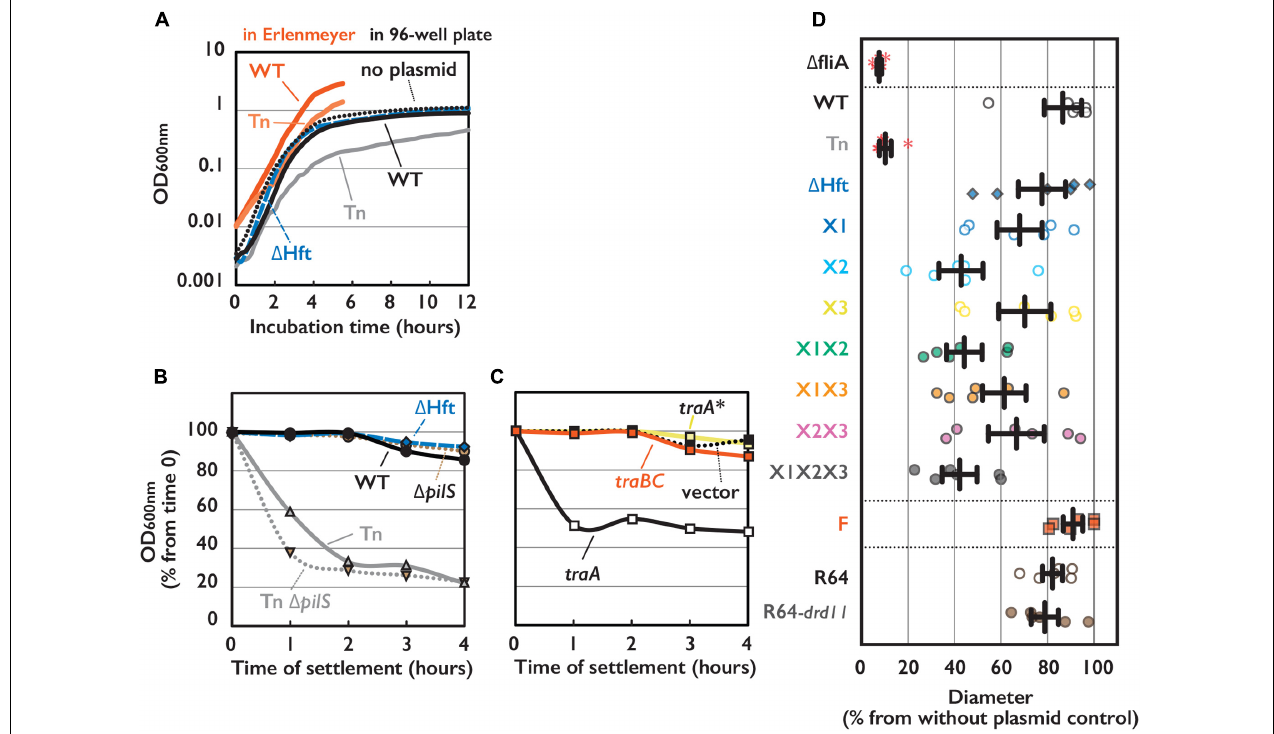
FIGURE 2 | Phenotypes of E. coli cells harboring conjugative plasmid. (A) Cell growth of E. coli strain harboring indicated plasmid measured by OD 600 nm with either conventional spectrometer or 96-well plate reader. (B,C) Sedimentation phenotype measured by OD 600 nm of culture supernatant settled on bench for indicated time. E. coli cells harboring WT or mutant of pESBL as indicated (B) or WT pESBL and an extra plasmid indicated for overexpression (C) . Average of at least 3 independent experiments were shown. (D) Motility phenotype measured by diameter of expansion on soft agar plate. Results of 6 independent experiments along with the mean and standard deviations were shown. (cid:49) fliA mutant without plasmid was used for the negative control. Red asterisks indicate no